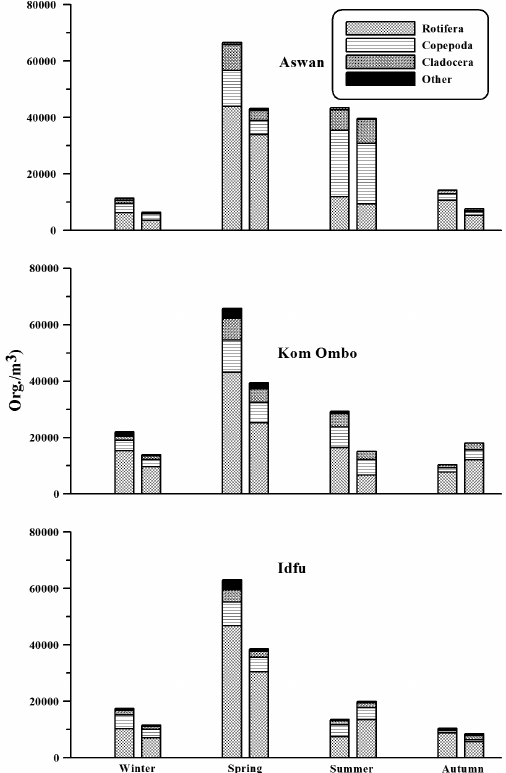
Figure 9. Seasonal variations of the Nile zooplank- ton Upper Egypt. Left bar (upstream) and right bar (Downstream).